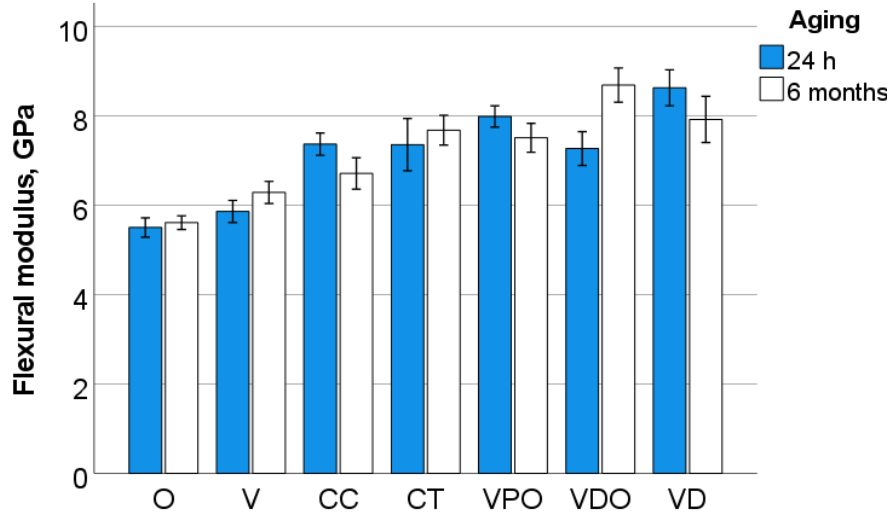
Figure 1. Flexural strength as a function of RBC and aging (mean values with 95% confidence inter- val).